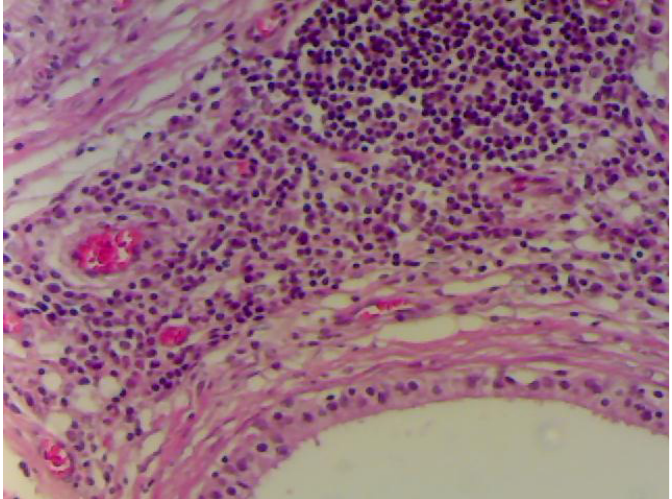
figure 2. Epididymis micrograph : inflammatory infiltrate with interstitial lymphocytes predominance (HeE) 40X.